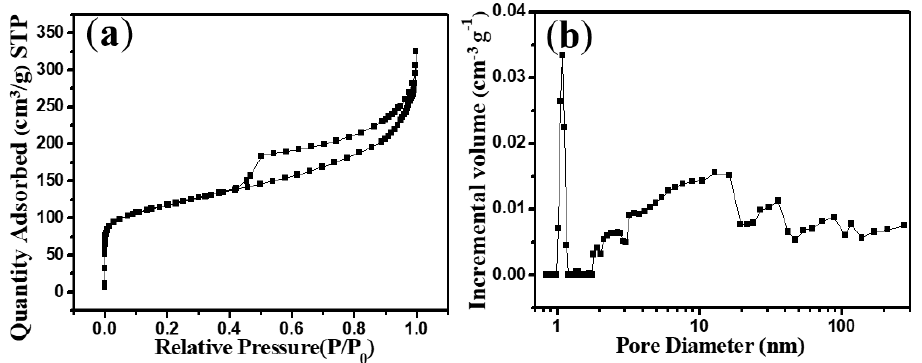
Figure 3. Nitrogen adsorption–desorption isotherms ( a ) and the corresponding pore-size distribu- tion curve ( b ) of Fe 3 C@N-F-GCNTs. XPS analysis (Figure 4a) shows that Fe 3 C@N-F-GCNTs is mainly composed of C (91.87 at.%), O (3.2 at.%), N (3.79 at.%), F (0.72 at. %), and Fe (0.42 at.%), confirming that